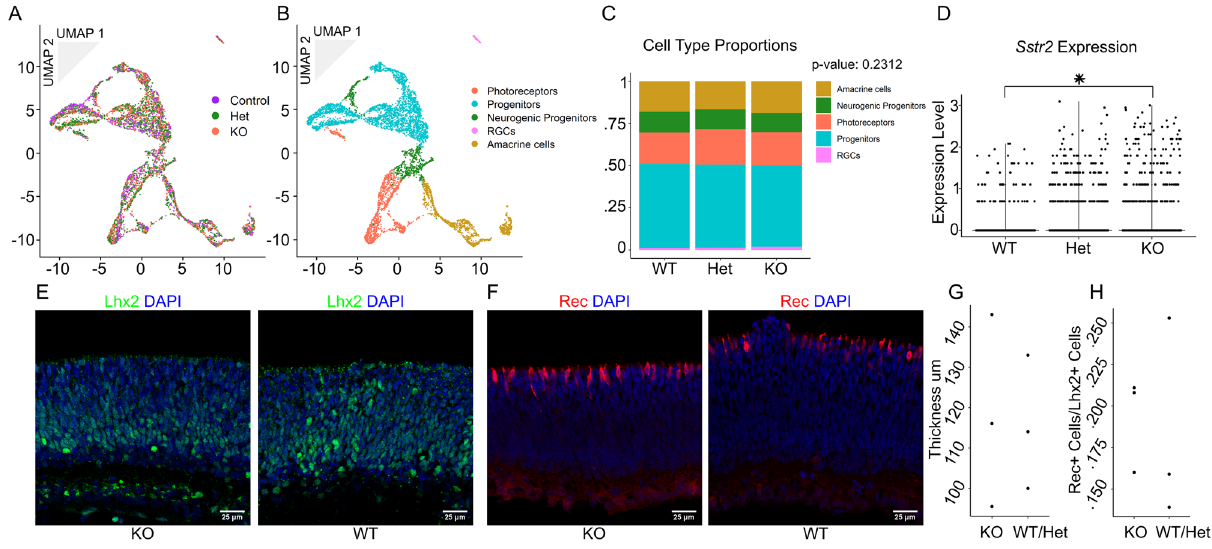
Figure 4. MULTI-seq and immunohistochemistry analysis of wildtype, Sstr2 +/− , and Sstr2 −/− littermates reveals no change in cell-type proportions at P0. n = 2 samples per genotype (except + / + where n = 1). n = 5,706 cells ( Sstr2 + / + : 1207, Sstr2 +/− : 2341, Sstr2 −/− : 2158). ( A ) 2D UMAP dimension reduction representation of the pooled retinal cells colored by genotype. ( B ) Cells colored by identified cell types. ( C ) Bar graph representation of the proportion of each cell type within each genotype. P -value for significance in difference of cell type proportions across genotypes were calculated using Pearson’s Chi-squared test. ( D ) Violin plot of expression of Sstr2 in cells for each condition. Was found to be significantly different by Seurat function ‘FindMarkers’. ( E – H ) P0 Retinas stained with ( E ) Lhx2 (green) or ( F ) Recoverin (red) antibodies and counterstained with DAPI (blue) with Sstr2 −/− in the left panel and Sstr2 +/+ in the right panel. Scale bars represent 25 μm. Dot plots representing ( G ) retinal thickness (n = 3) and ( H ) the density of Rec + cells corrected by the density of Lhx2 + cells for that biological replicate (n = 3). No significant difference found by Welch’s two-sample